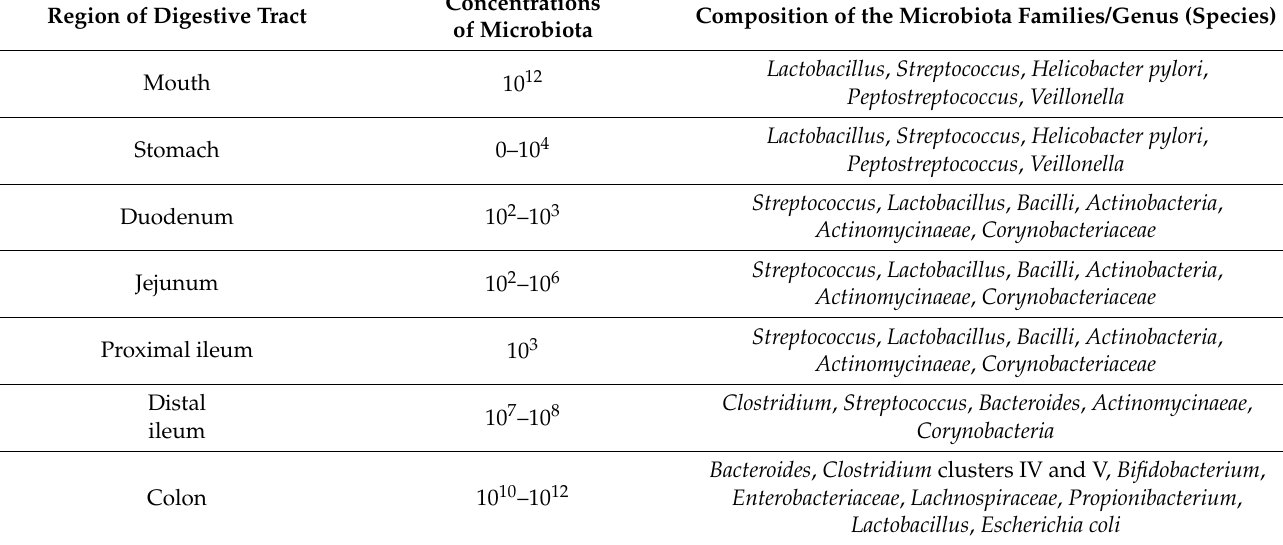
Table 1. The composition and concentrations of microbiota in healthy human digestive tract with regard to body parts. The concentration of bacteria is presented as number of cells per gram of luminal content [3,14,15,19]. Region of Digestive Tract